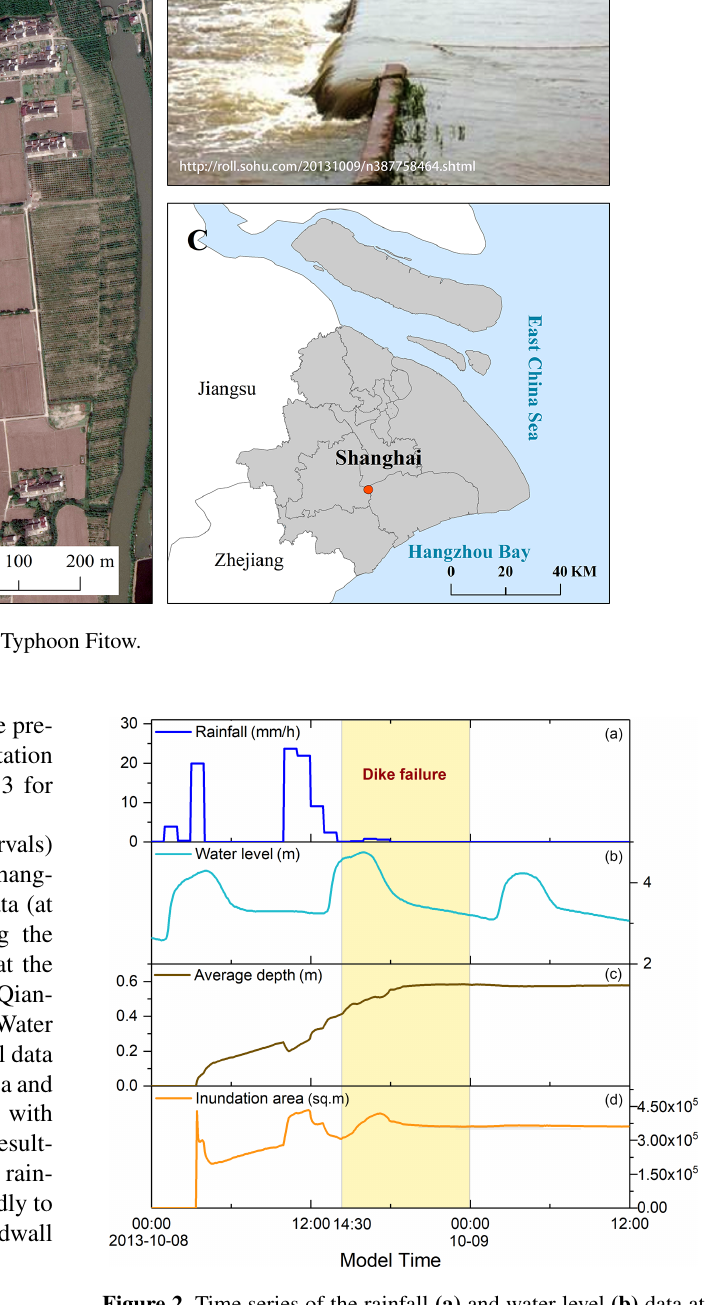
Figure 2. Time series of the rainfall (a) and water level (b) data at Qianbujing Creek during Typhoon Fitow; time series of simulated average water depth (c) and inundation area (d)